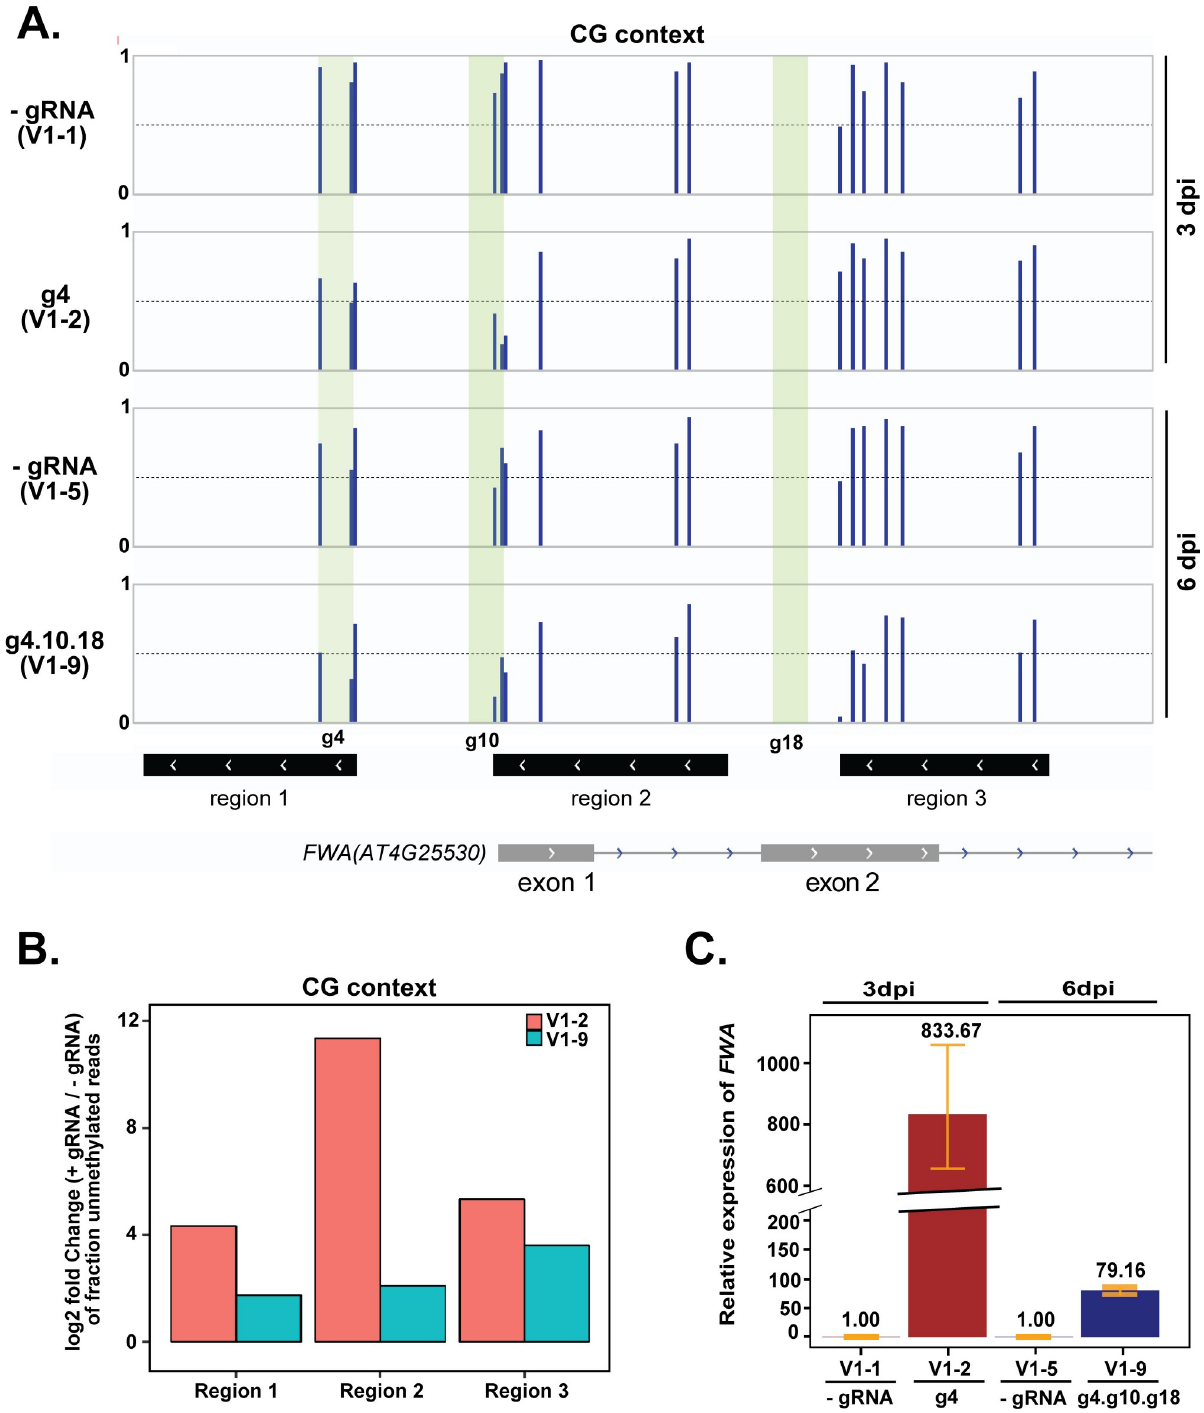
Fig 2. TRV-mediated guide RNA delivery in SunTag-TET1 plants triggers DNA demethylation and transcriptional activation of FWA . (A) Bisulfite PCR sequencing of two +gRNA lines (V1-2, V1-9) and their matched -gRNA controls (V1-1, V1-5) over three regions of the FWA promoter region: region 1 (Chr4:13038143 to 13038272), region 2 (Chr4:13038356 to 13038499) and region 3 (Chr4:13038568 to 13038695), using genomic DNA extracted from rosette leaves of TRV inoculated plants collected at 3 and 6 dpi. Only CG sites are shown. An average of 30,000 to 50,000 reads were obtained for each of the three regions. Green stripes denote guide 4, guide 10 and guide 18 binding site. (B) Data shown in (a) was displayed as a bar graph of the log 2 ratio of the fraction of fully CG-demethylated reads in +gRNA plants relative to their matched -gRNA controls. (C) FWA expression in +gRNA lines compared to control plants by reverse transcriptase-qPCR. Each +gRNA and its matched control were normalized so that expression